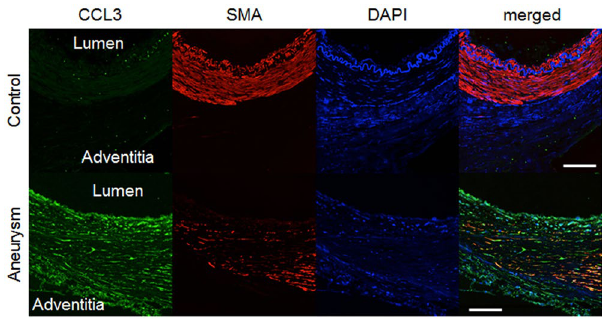
Figure 3. Induced expression of CCL3 protein in intracranial aneurysm lesions. Specimens from control arterial walls (Control) and intracranial aneurysm lesions (Aneurysm) were immunostained. Images of immunostaining for CCL3 (green), α -smooth muscle actin (SMA) as a marker of medial smooth muscle cell (red), nuclear staining by DAPI (blue) and merged ones are shown. Bar, 20 μ m. Representative images from 2 (Control) and 4 (Aneurysm) independent specimens are shown in this figure and images from remaining samples are shown in Supplementary Fig.